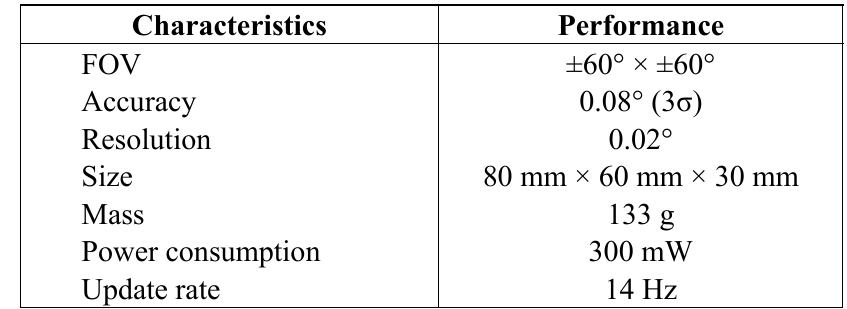
Table 1. Performance of sun